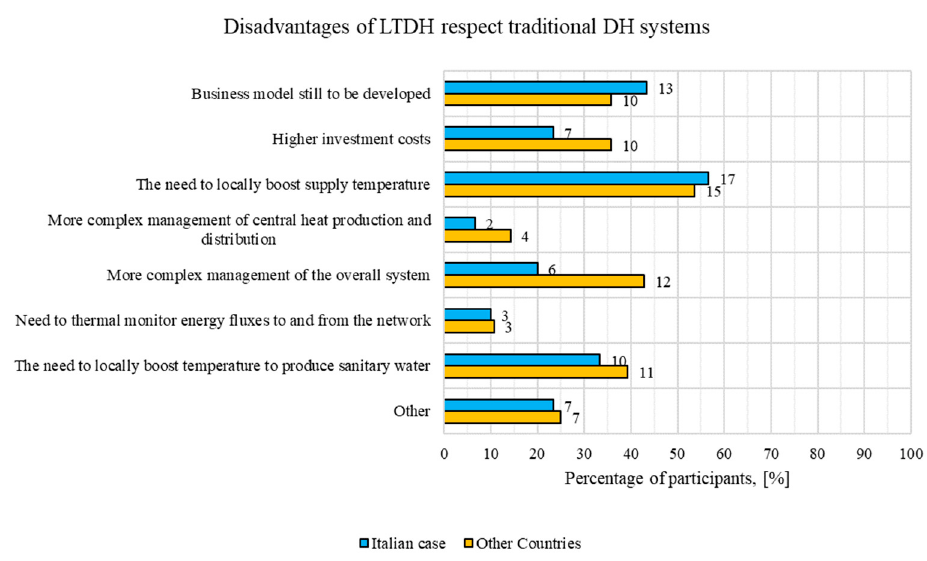
Figure 25. Disadvantages of LTDH systems with respect to traditional DH systems.